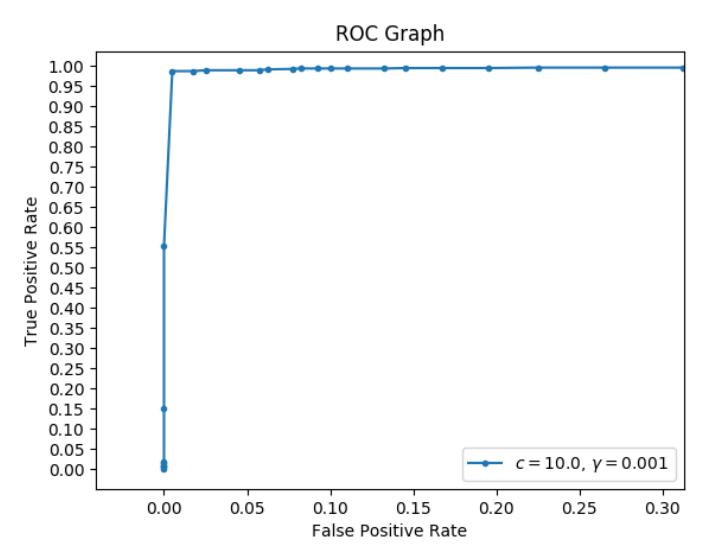
Figure 10. ROC graph of the SIPR stopping criterion classifier (different from that in